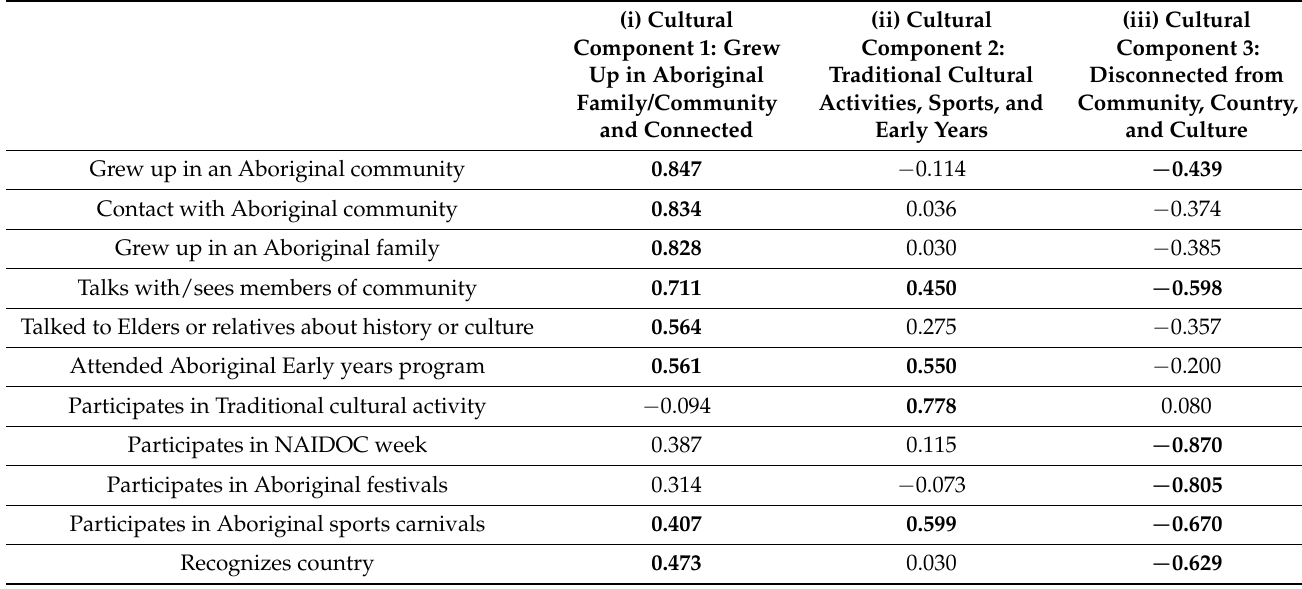
Table 3. Principal component analysis of cultural determinants ( n = 68; includes all participants with a complete profile).